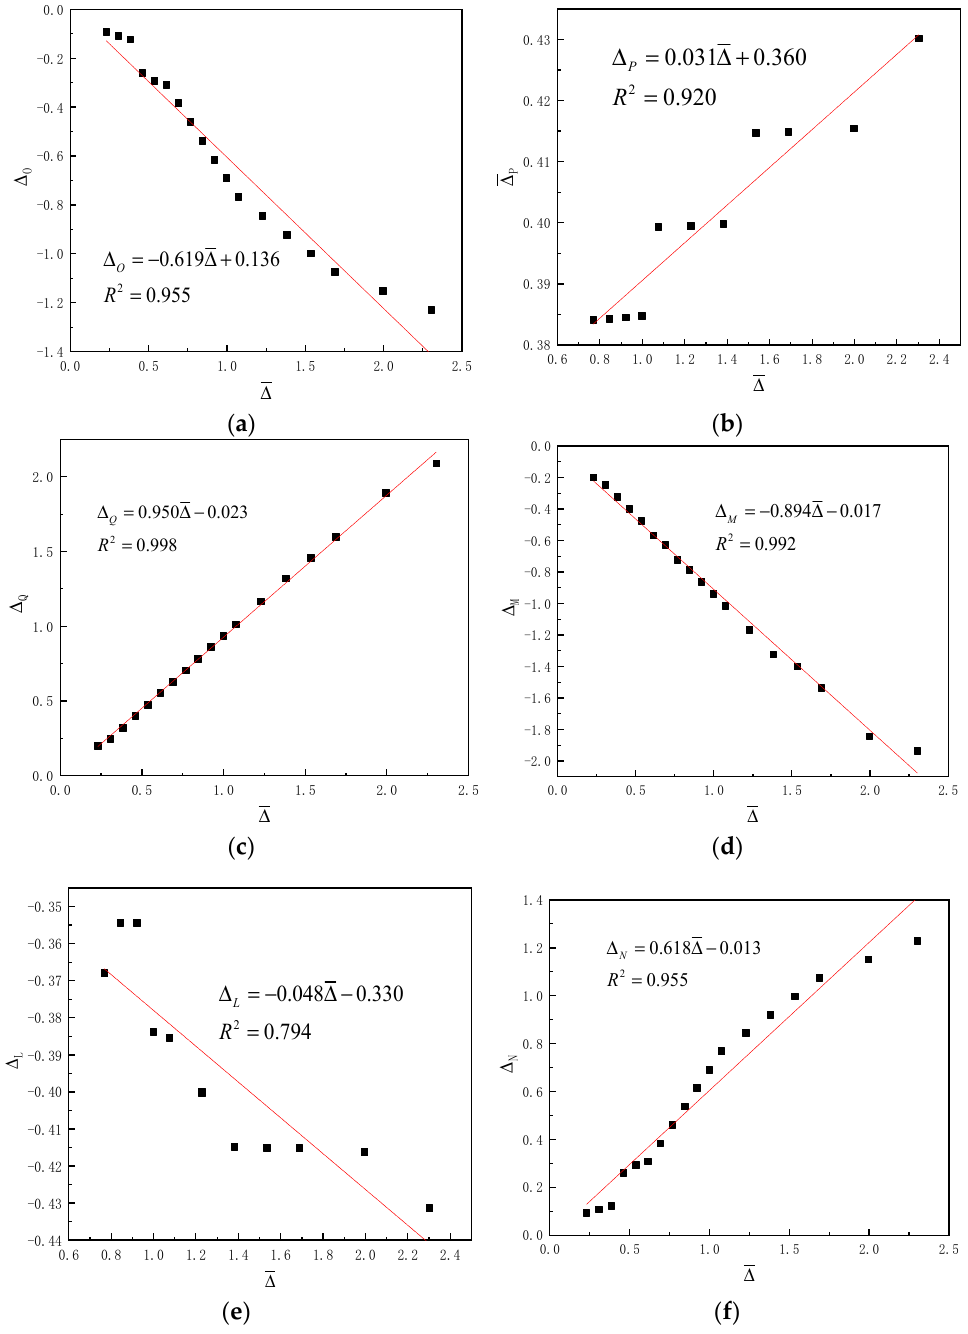
Figure 18. Fitting curves of the piecewise points: ( a ) Point O; ( b ) Point P; ( c ) Point Q; ( d ) Point M;